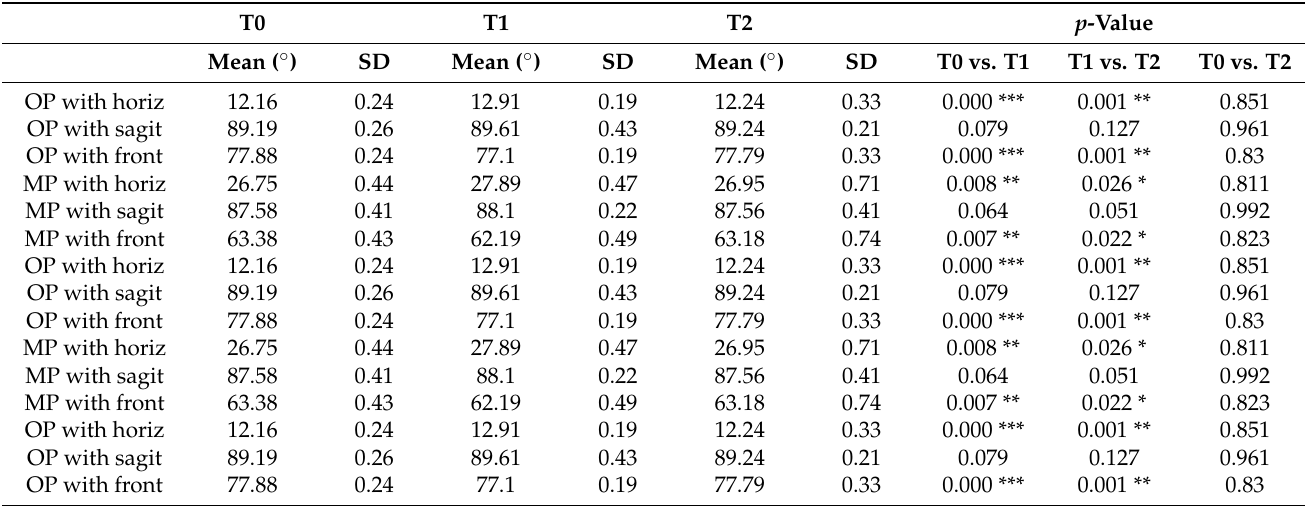
Table 6. Angular changes in mandibular measurement planes at T0, T1 and T2.